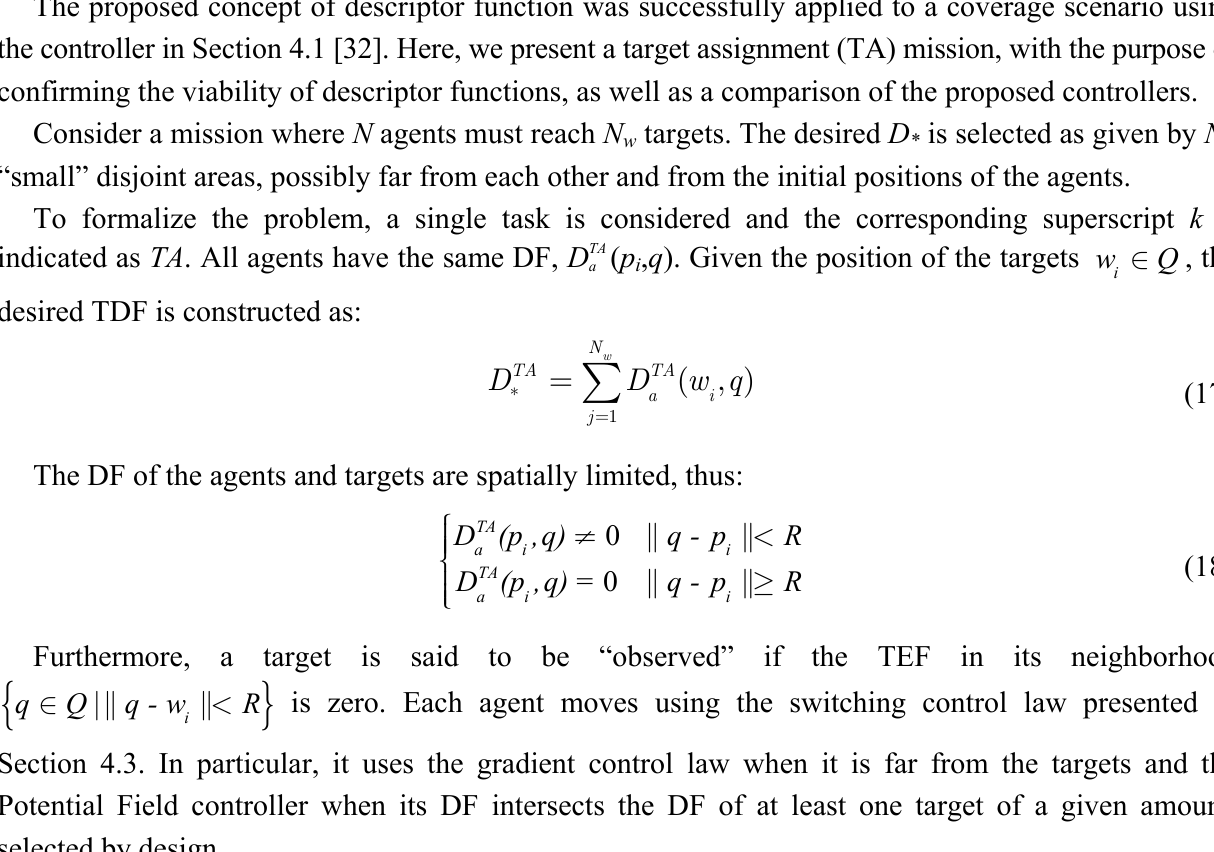
Figure 3. Here, the cost function behavior clearly shows how the combined control law (switching controller) achieves the optimal